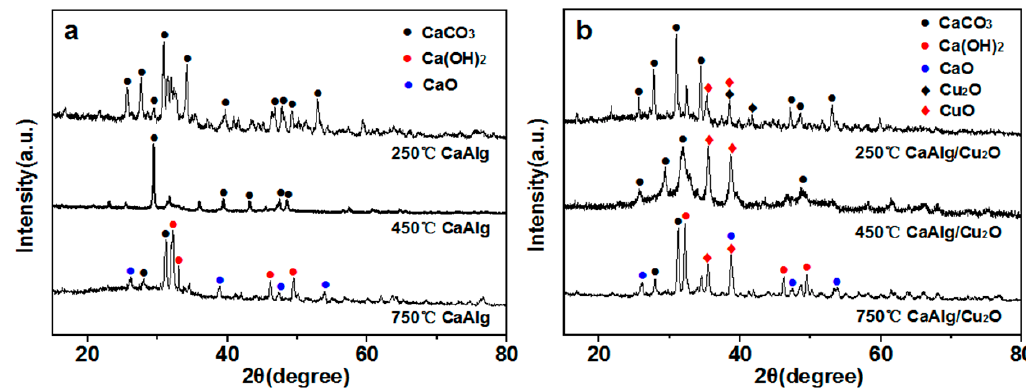
Figure 5. XRD patterns of calcined residue at different temperatures: ( a ) CaAlg and ( b ) CaAlg/nano-Cu 2 O hybrid material.